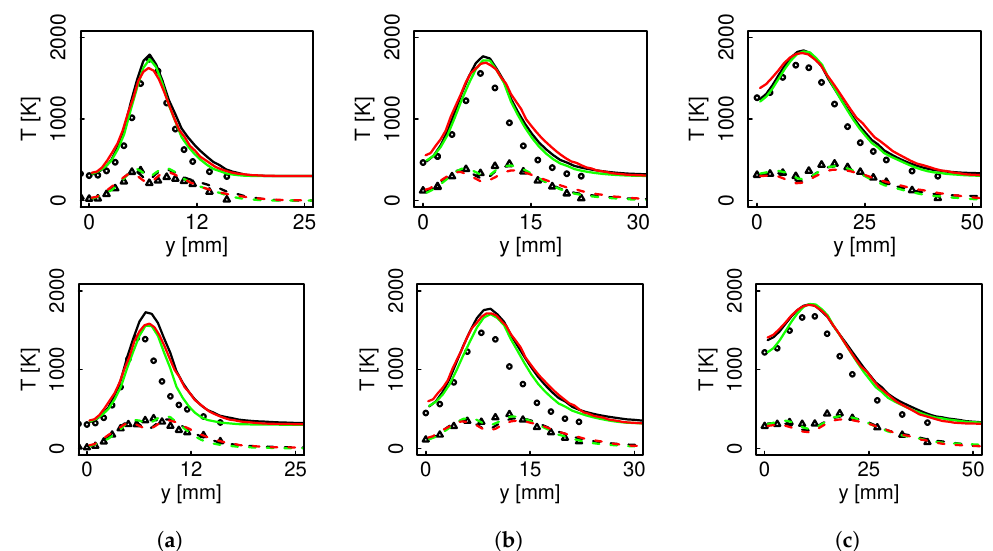
Figure 8. Temperature mean and RMS radial profiles for flame D ( top ) and E ( bottom ). Black color represents non-premixed FTACLES, green color premixed FTACLES, red color FPV, solid line mean, dashed line RMS. Circles depict experimental mean, and triangles experimental RMS. ( a ) x / d = 7.5; ( b ) x / d = 15; ( c ) x / d =